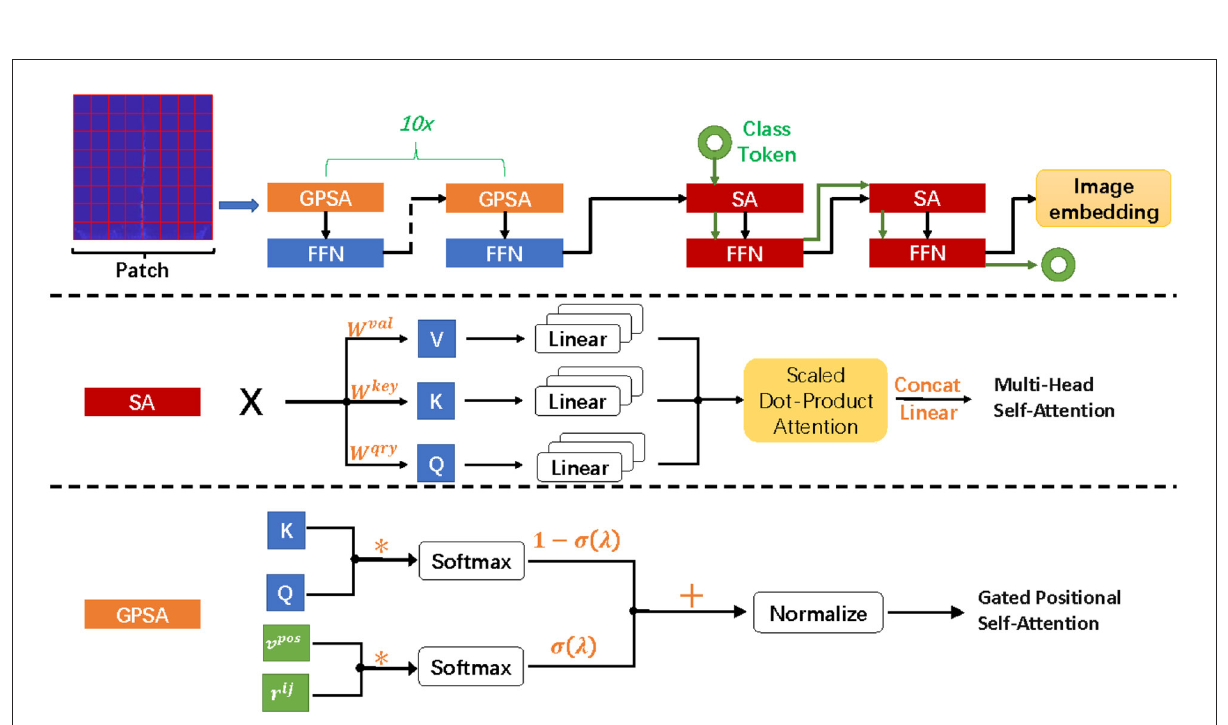
FIGURE3 Framework of ConViT and the details of SA and